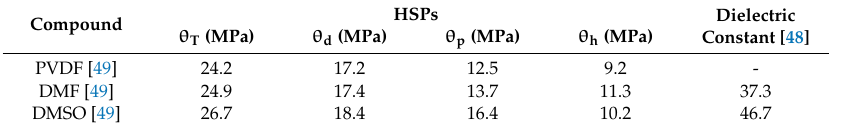
Table 3. Hansen solubility parameters (HSPs) for polymer and solvents used in this work.